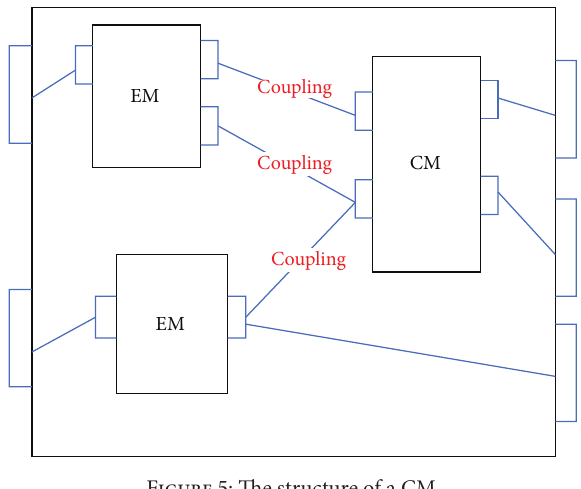
Figure 5: The structure of a